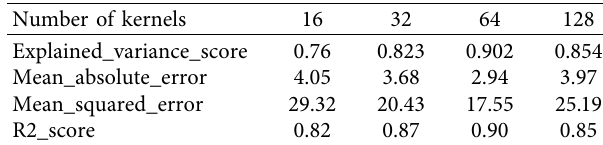
Table 1: Average test loss with different number of kernels in convolution layers.